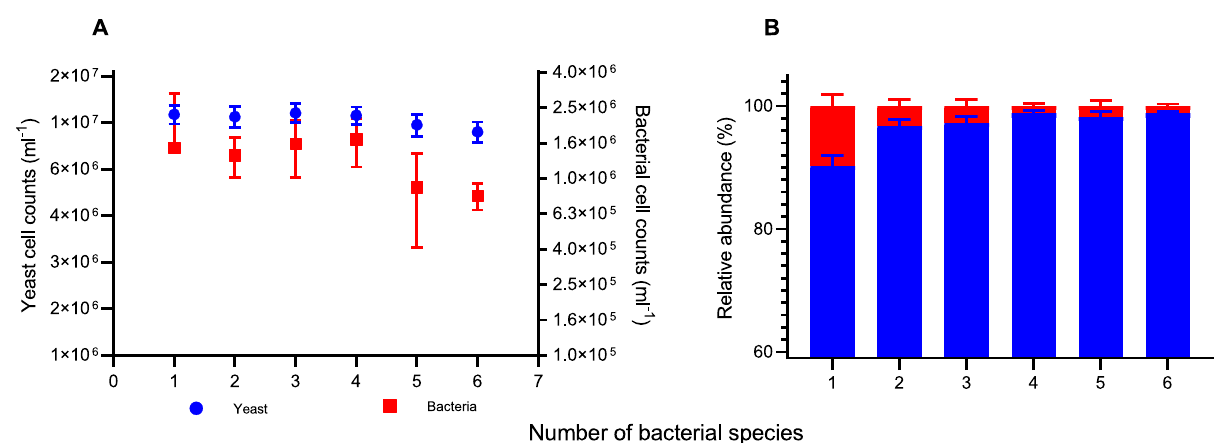
Fig. 2 The community structure of yeast and bacteria co-cultivations. A Final cell counts of yeast (blue) and bacteria (red) from different community structures. The fi nal yeast cell counts dropped from 1.1 × 10 7 ± 1 × 10 6 to ca . 9.1 × 10 6 ± 9.3 × 10 5 cells mL − 1 as the number of bacterial species in the community increased (one-way ANOVA, p < 0.0001). The fi nal bacterial cell counts dropped from 1.5 × 10 7 ± 1.5 × 10 6 to ca . 8 × 10 5 ± 1.4 × 10 5 cells mL − 1 (one-way ANOVA, p = 0.0002). Symbols and error bars represent the mean ± standard deviation. B The relative abundance of yeast and bacterial populations in different community structures. The relative abundance of the yeast population (blue bar) increased from 90.3 ± 1.6% in pairwise cultivations to 98.8 ± 0.3% in the presence of all six different bacterial species (one-way ANOVA, p < 0.0001). The bacterial relative abundance (red bar) decreased from 9.7 ± 1.8% initially in pairwise cultivations to 1.2 ± 0.3% in the most complex community tested, which contained yeast and six different bacterial species (one-way ANOVA, p < 0.0001). Columns and error bars represent the mean ± standard deviation. For all the results presented in the fi gure, n = 3 independent experiments. Source data are provided as a Source Data fi